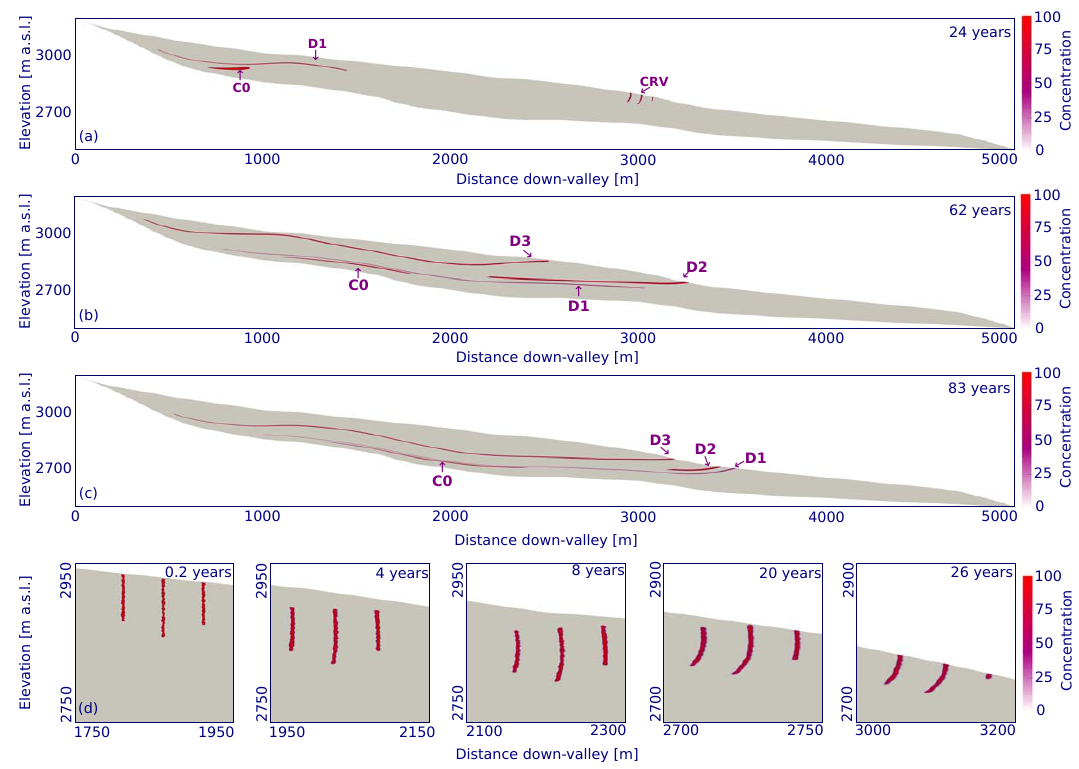
Figure 9. Results of the debris transport simulations for the 2-D long profile of Haute Glacier d’Arolla, where C0 indicates the circular debris inclusion, D1–D3 the surface debris layer deposits and CRV the crevasse fills. Debris concentration (a) at 24 years, (b) at 62 years and (c) at 83 years after start of the simulations. Concentrations are displayed in the range of 0 to 100 and numerical oscillations as excursions beyond the initial values of 0 or 100 are of magnitude less than ± 17 and are truncated to the data limits. (d) Zoom of the crevasse fills at 0 . 2, 4, 8, 20 and 26 years after the start of the